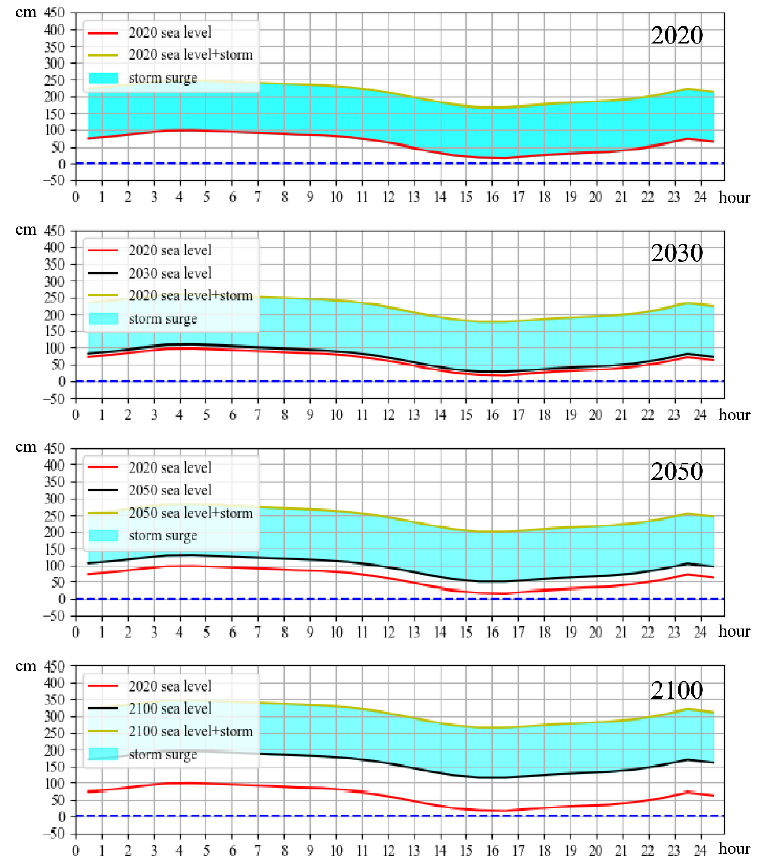
Figure 22. Sea-level simulation. The above four figures show the simulated sea-levels. The storm surge is displayed as an interval and is blue filled.